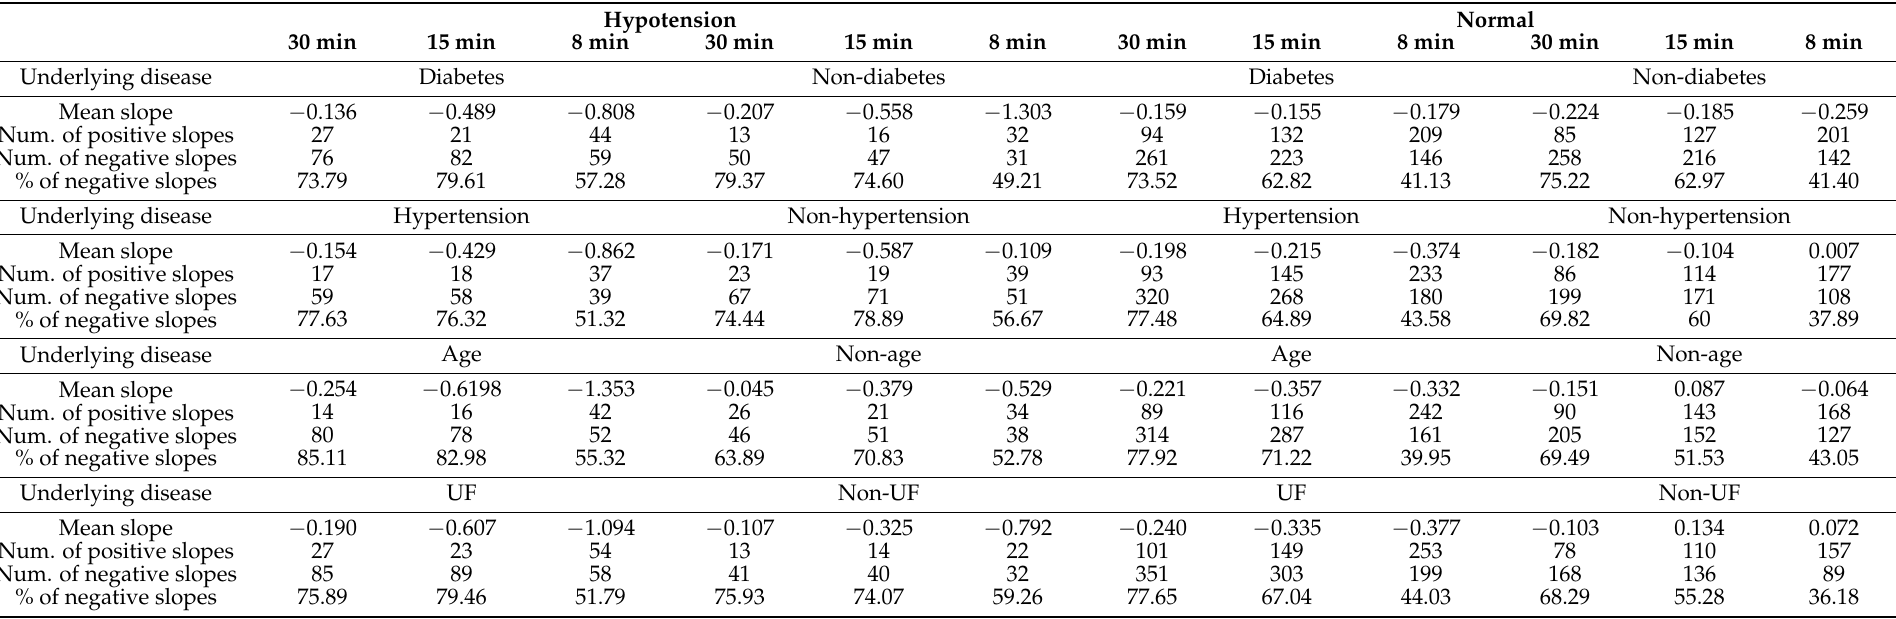
Table 4. HR slope values for IDH and normal (non-IDH) patients according to patient baseline information 30 min before IDH